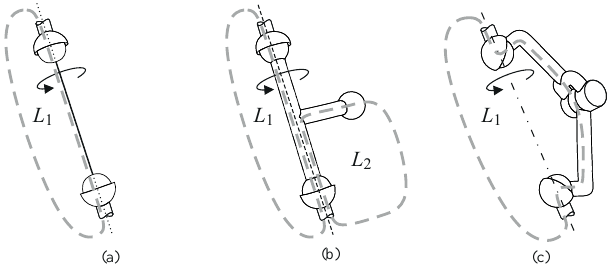
Figure 4. Different types of isolated DOFs: (a) “ Fully isolated ”, (b) “ transmitted isolated ”, (c) “ structurally isolated ”.